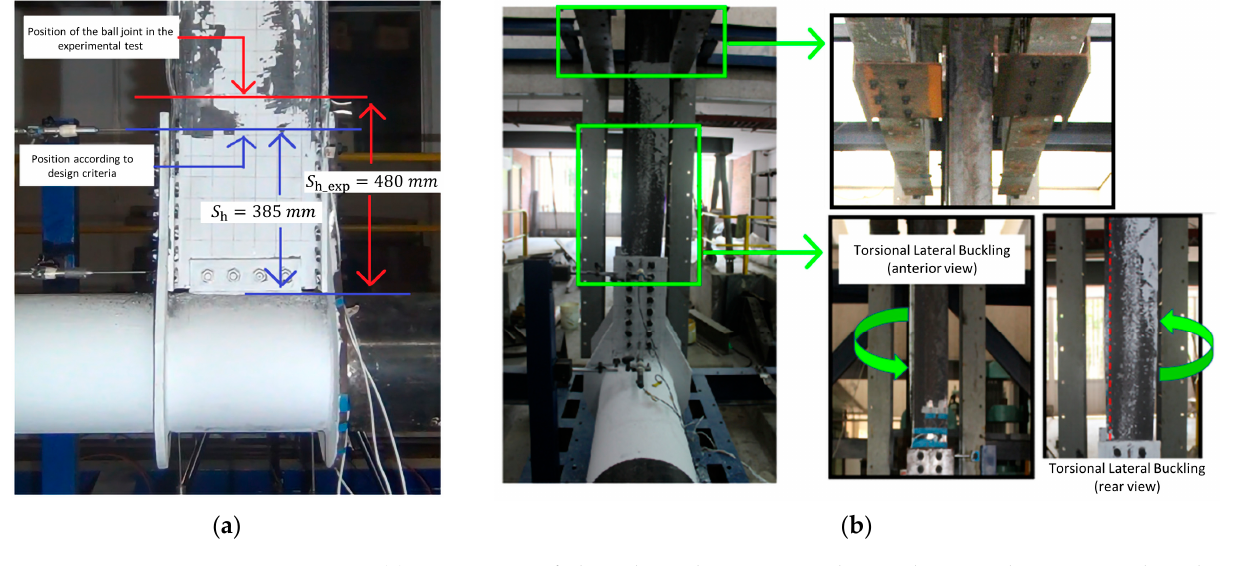
Figure 9. Final state of the specimen during the test seen from different angles.